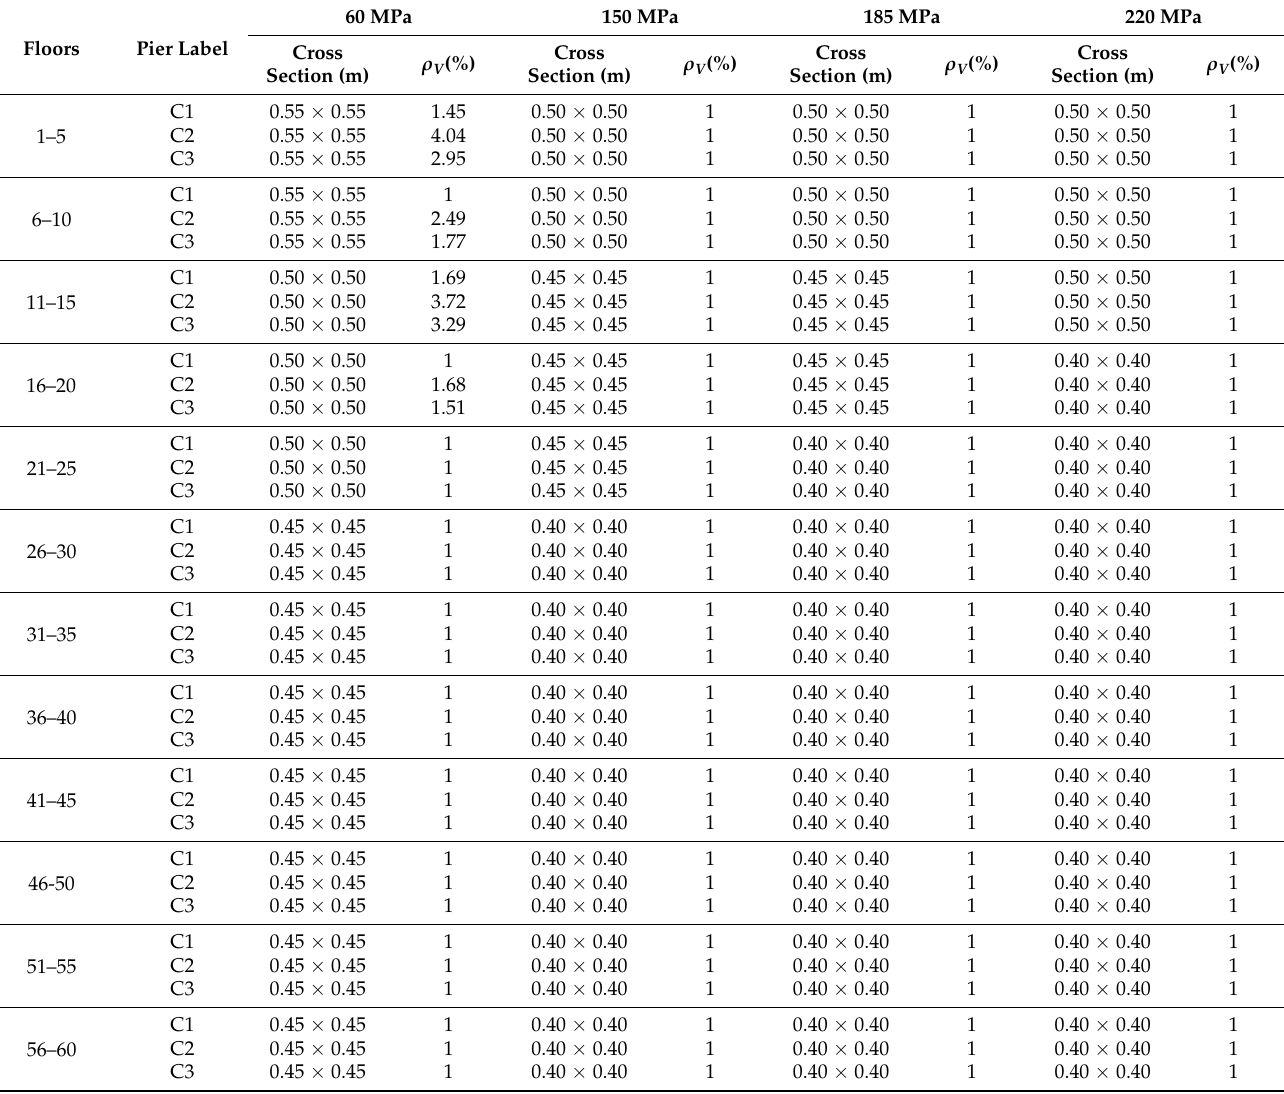
Table notations: ρ V (vertical reinforcement